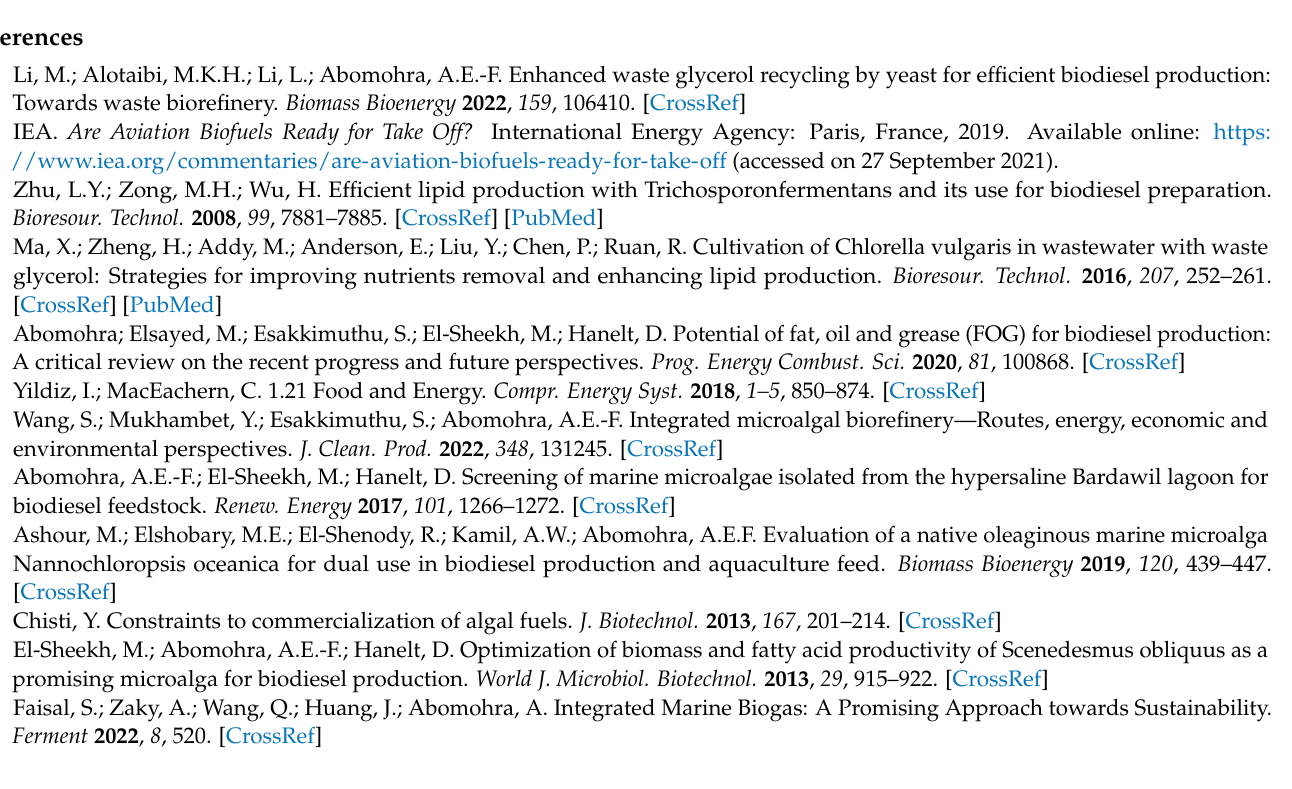
Table S1: The experimental runs of the optimization experiment using randomized central composite design; Table S2: ANOVA analysis for central composite design of lipid productivity responses at different studied conditions of sodium nitrate, seawater, and glycerol; Table S3: ANOVA analysis for central composite design of nitrogen removal responses at different studied conditions of sodium nitrate, seawater, and